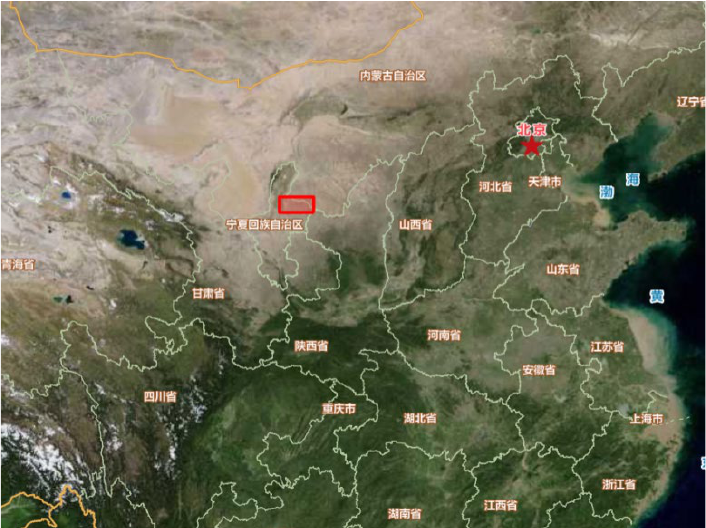
Figure 7. The geographic locations of an oilfield in China.